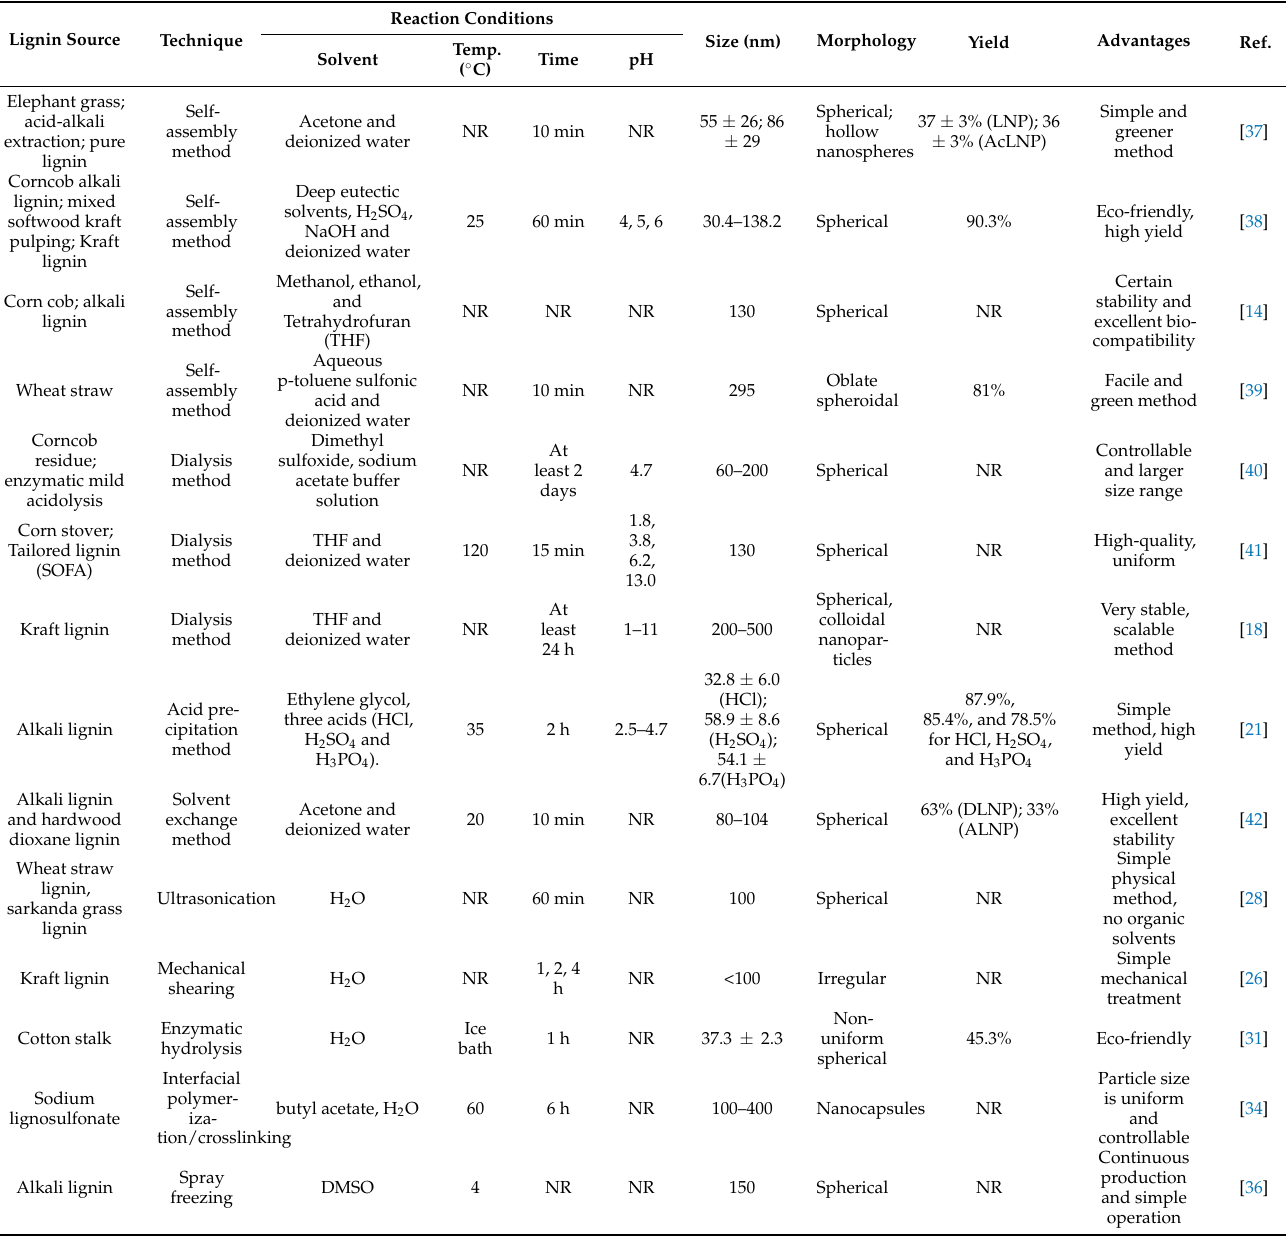
Table 1. Preparing LNPs by different